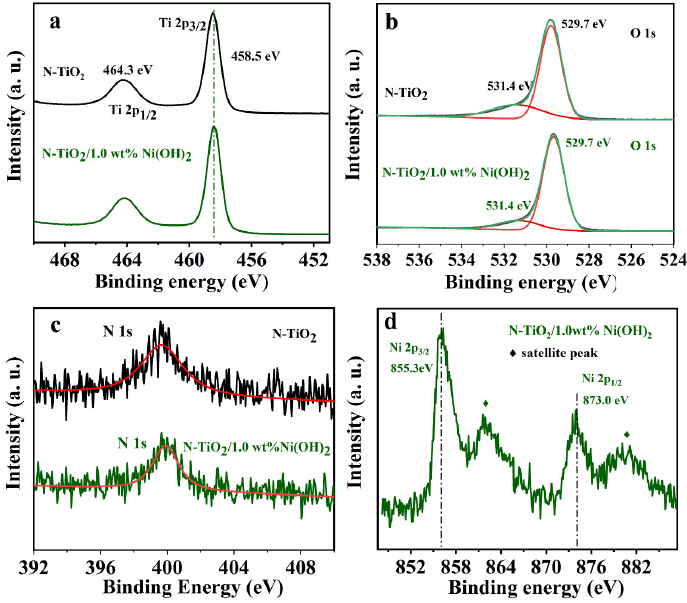
Figure 3. XPS spectra of ( a ) Ti 2p, ( b ) O 1s, ( c ) N 1s, and ( d ) Ni 2p of N-TiO 2 /1.0 wt% Ni(OH) 2 nanofibers. The red lines in ( b , c ) are the fitted curves of the corresponding data.